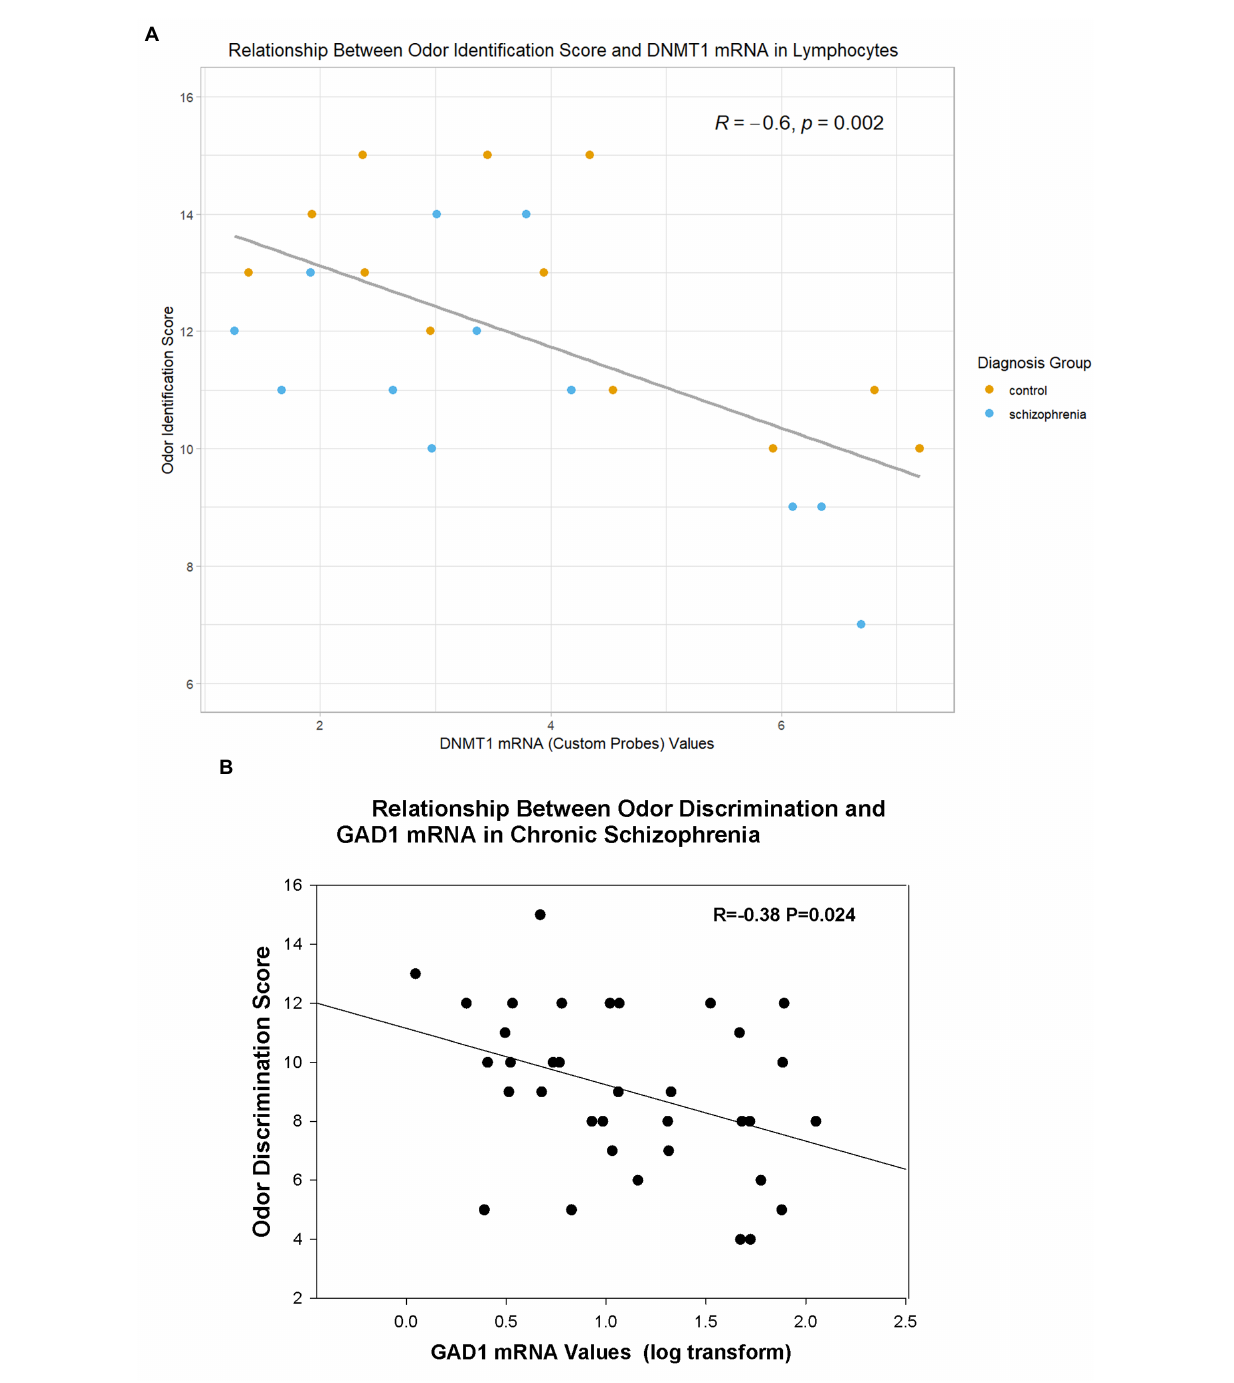
FIGURE 2 Relationship of Odor Variables to Selective mRNA Expression in Lymphocytes. (A) Relationship of DNMT1 (Custom Probe) to Odor Identification (in all subjects with DNMT1 CP values). (B) Relationship of GAD1 mRNA to Odor Discrimination in Subjects With Schizophrenia. R=Pearson correlation